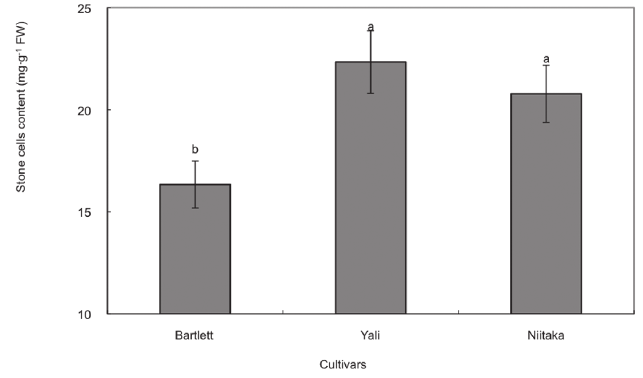
Fig. 2: Comparisons of stone cell contents in ‘Bartlett’, ‘Yali’, and ‘Niitaka’ pears at 160 DAFB. z Vertical bars represent±SD. Results are from twenty fruits, respec- tively. Mean separation within columns by Duncan’s multiple range test at 5 %